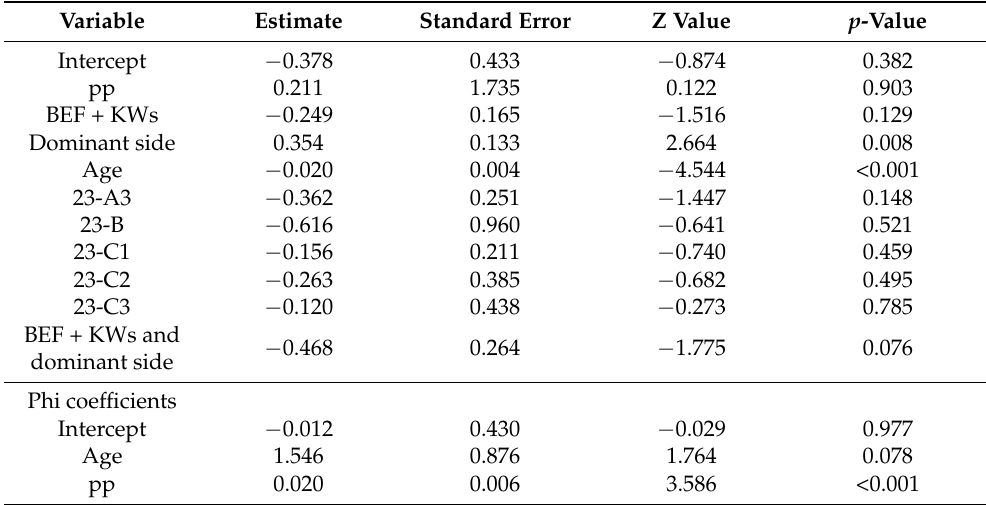
Table 4. Beta multivariate regression analysis of the impact of the different variables on QuickDASH